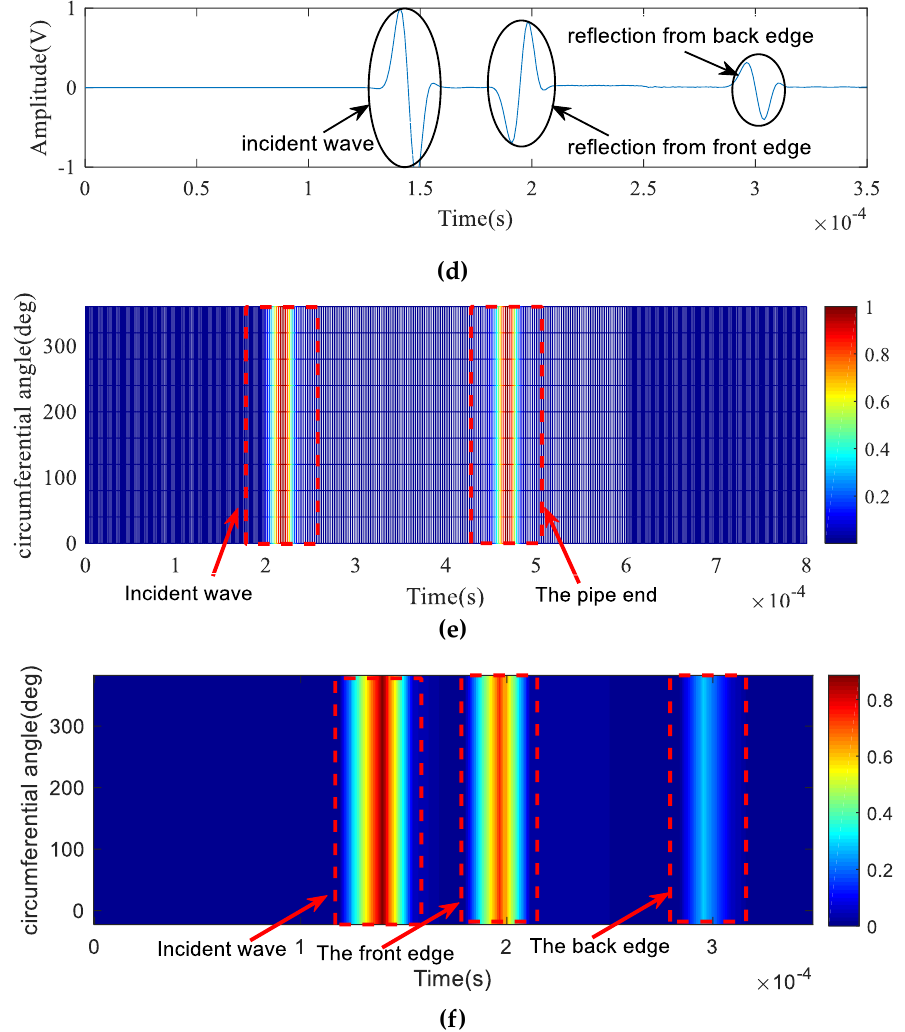
Figure 3. Numerical simulation results of guided-wave A-scan and circumferential scanning in pipes by finite element software: ( a ) an undamaged pipe; ( b ) a pipe with a girth weld; ( c ) A-scan signal of the pipe; ( d ) A-scan signal of the girth weld; ( e ) circumferential scanned image of the pipe; ( f ) circumferential scanned image of the girth